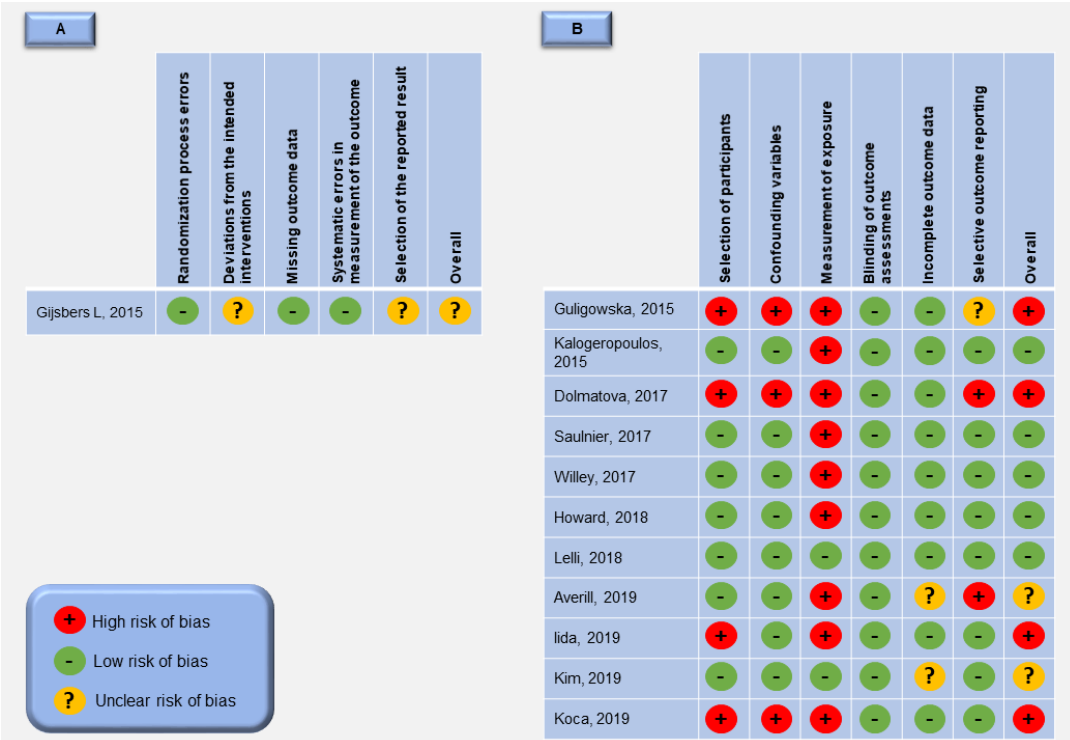
Figure 2. Risk of bias summary: review authors’ judgements about each risk of bias item for each included study. ( A )—randomized controlled trials included; ( B )—non-randomized studies included.